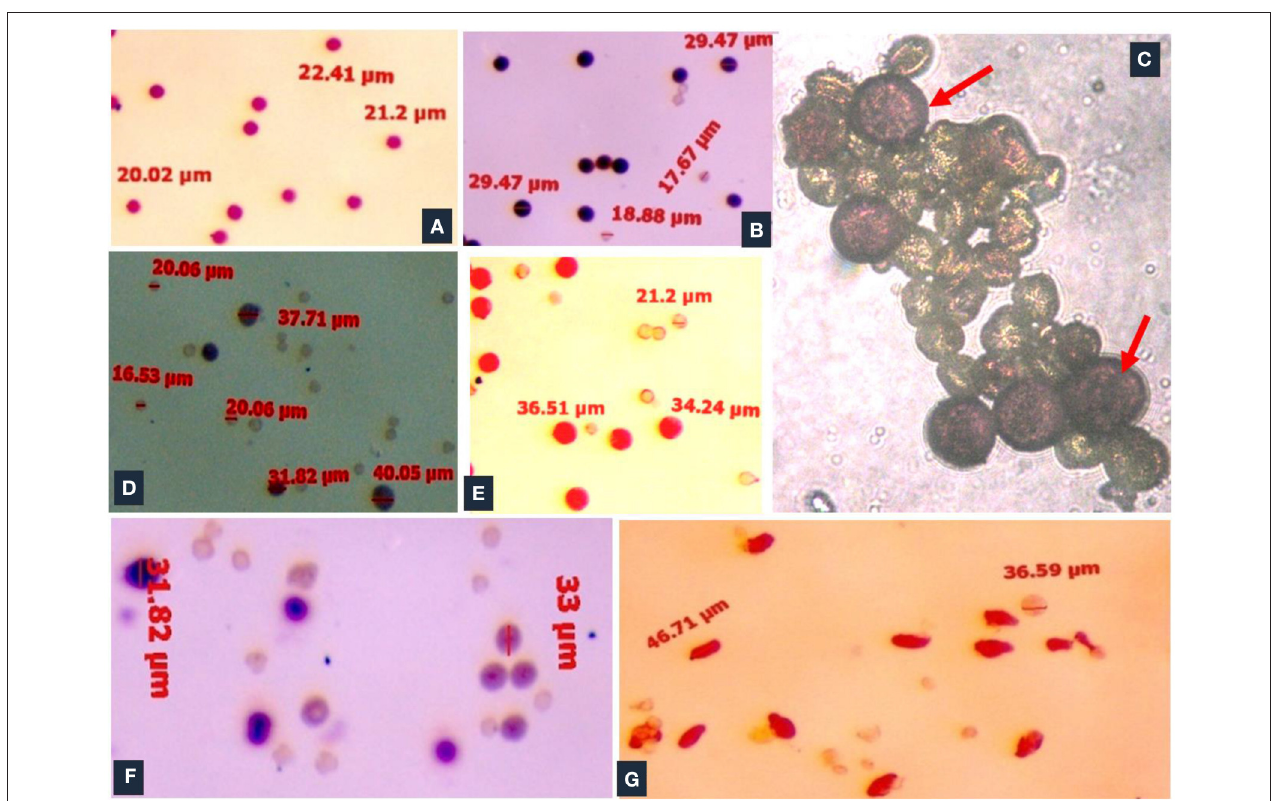
FIGURE 5 | Pollen viability studies of inter-specific hybrids and BC 1 population. (A) Cauliflower “Pusa Sharad.” (B) B. carinata “NPC-9.” (C) Frequent occurrence of pollen giant (red arrow) and others as normal pollen in F 1 hybrids. (D) Poor pollen viability in inter-specific F 1 hybrids. (E–G) BC 1 individuals showed low to high pollen